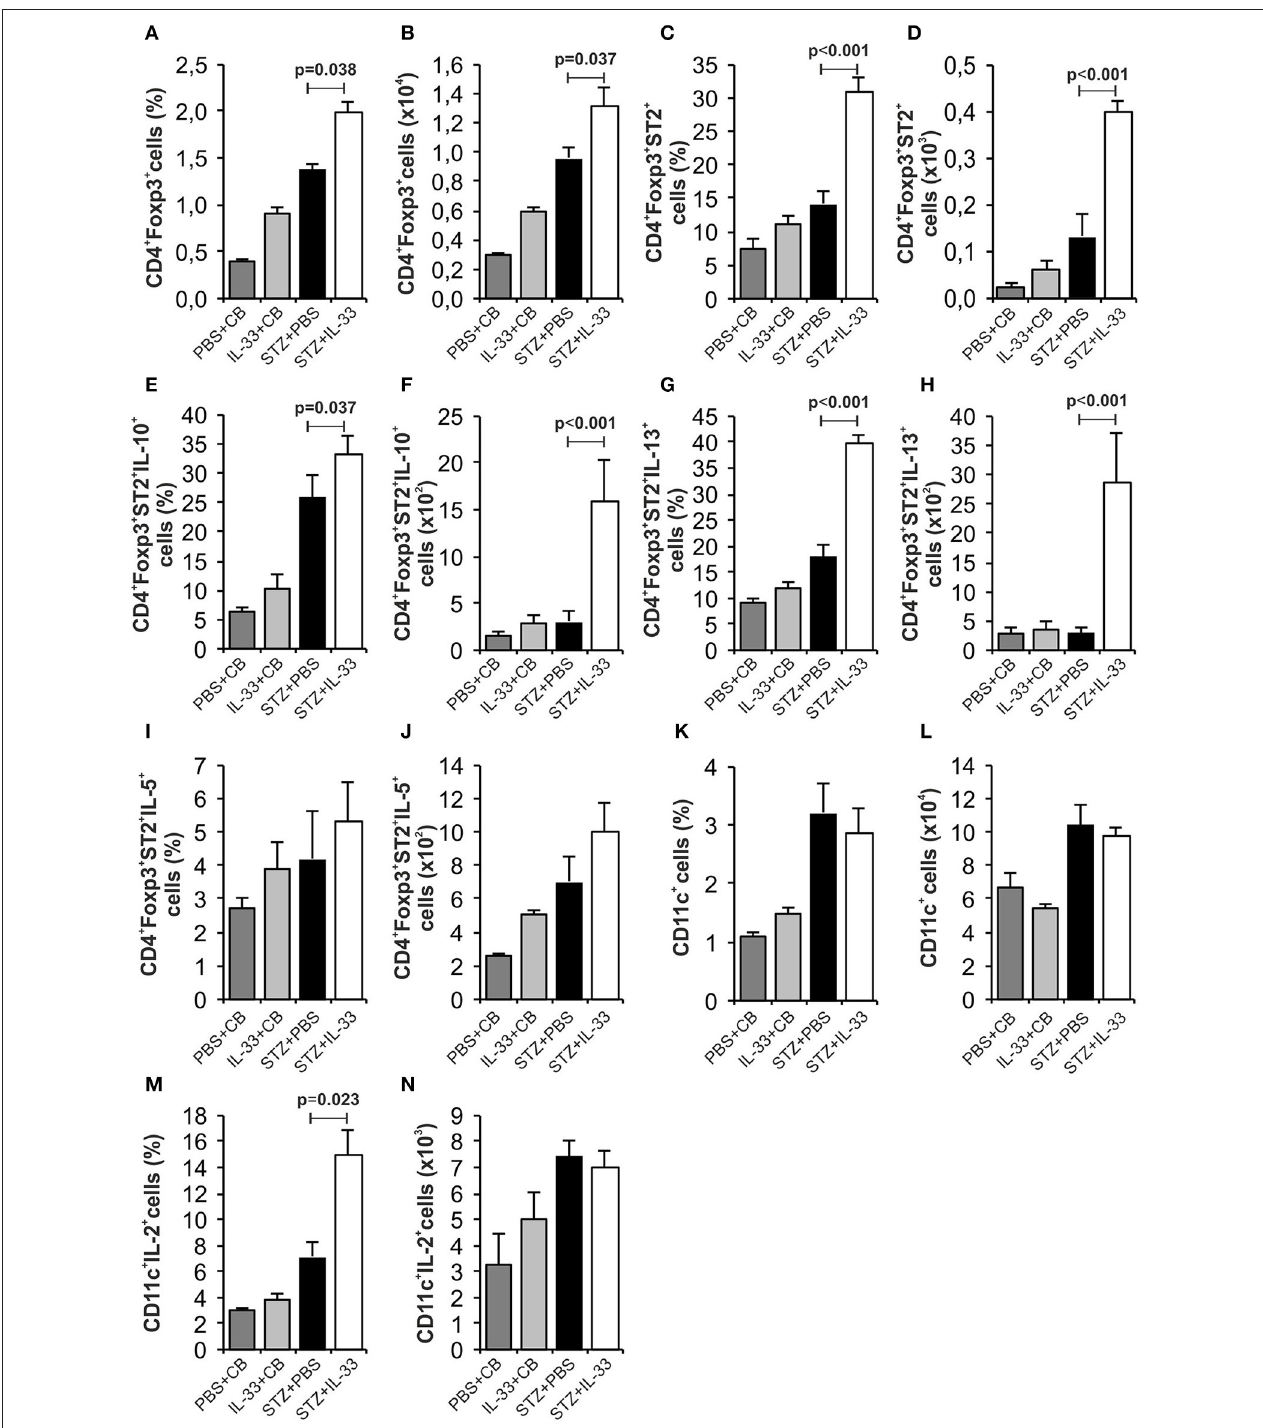
FIGURE 3 | Exogenous IL-33 significantly increases the percentage and total number of regulatory T cells (Foxp3 + ST2 + IL-10 + ) in the pancreatic lymph node. The percentage and total number of CD4 + Foxp3 + (A,B) , CD4 + Foxp3 + ST2 + (C,D), CD4 + Foxp3 + ST2 + IL-10 + (E,F) , CD4 + Foxp3 + ST2 + IL-13 + (G,H) , CD4 + Foxp3 + ST2 + IL-5 + (I,J) , CD11c + (K,L) , CD11c + IL-2 + (M,N) were examined. The animals were treated with 0.4 µ g/injection IL-33 together with MLD-STZ (i.p. 40 mg/kg for 5 consecutive days) or of an equimolar dose of PBS or with 0.4 µ g/injection IL-33 together with citrate buffer. Cells were obtained from pancreatic lymph nodes on day 28 after diabetes induction. Data from two individual experiments with at least 8 mice per group are shown as mean ± SEM; by paired t -test when compared with values obtained with phosphate-buffered